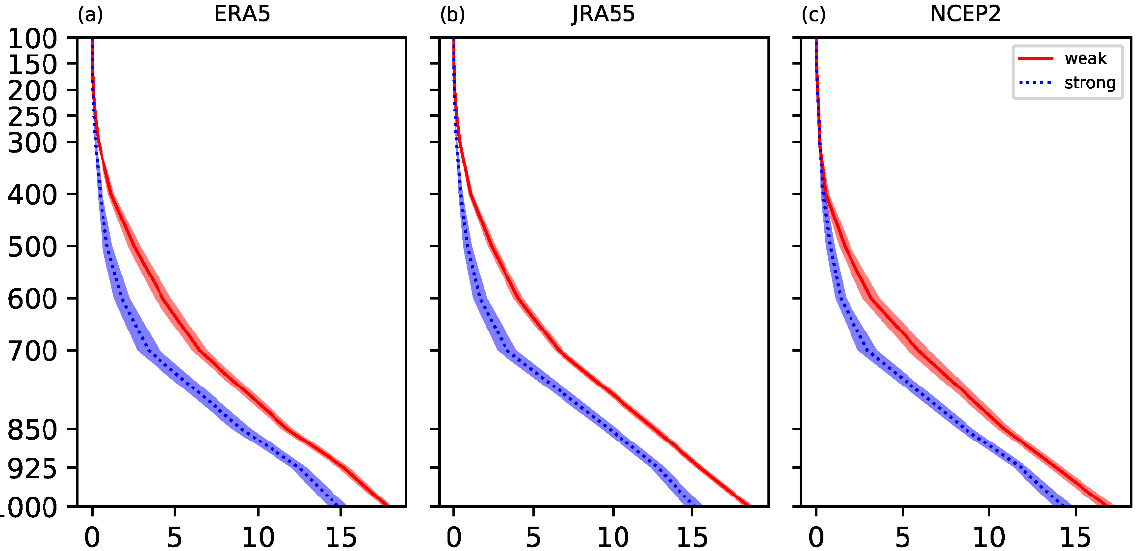
Figure 3. The contents are similar to Figure 2, but the areas squared are oceanic areas. ( a ) ERA5 datasets, ( b ) JRA55 datasets, and ( c ) NCEP2 datasets.